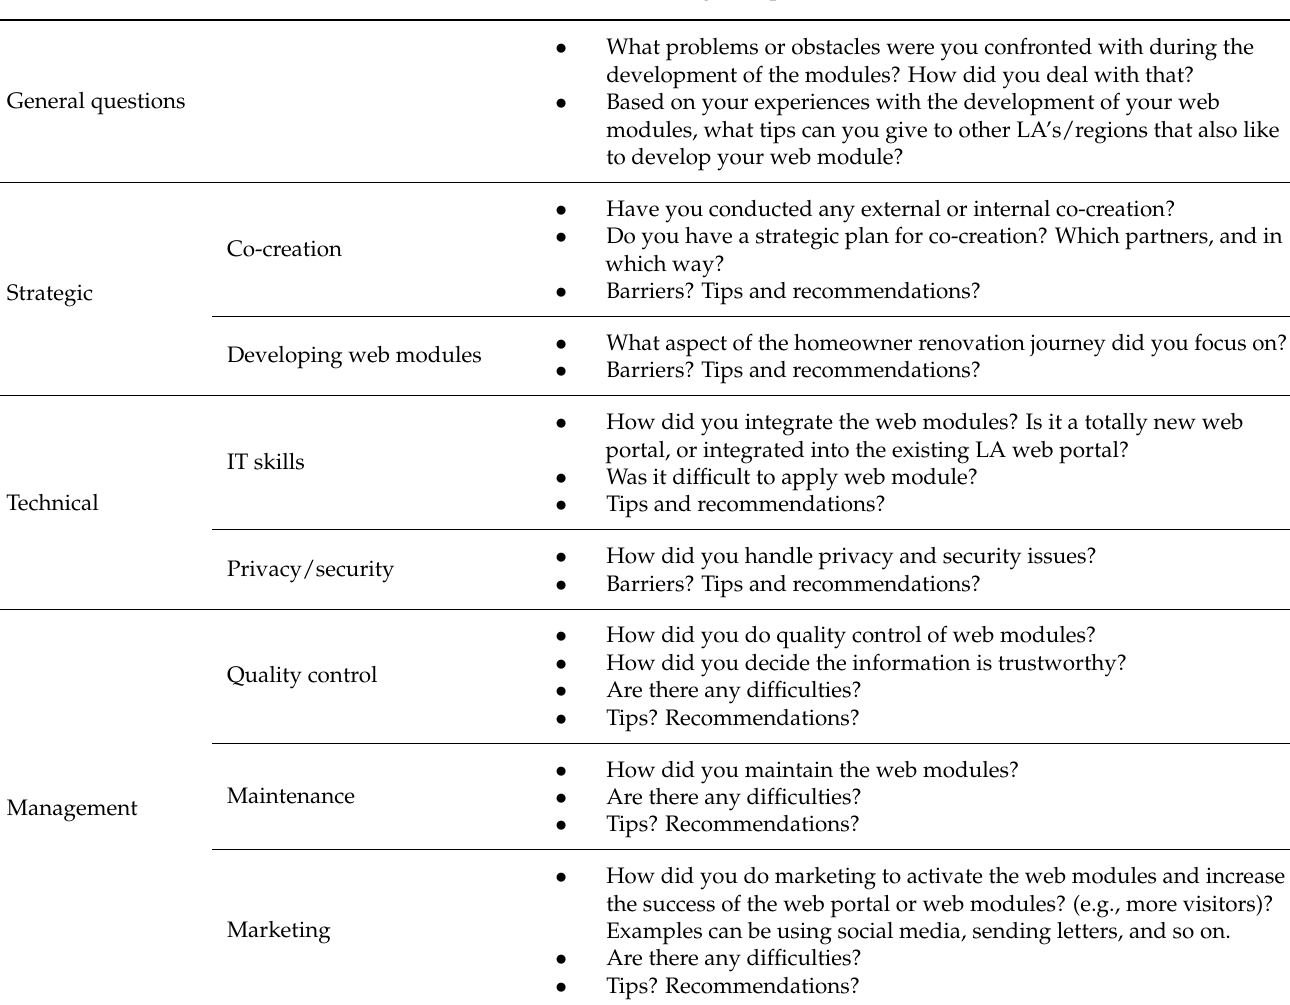
Table A2. List of interview-guide